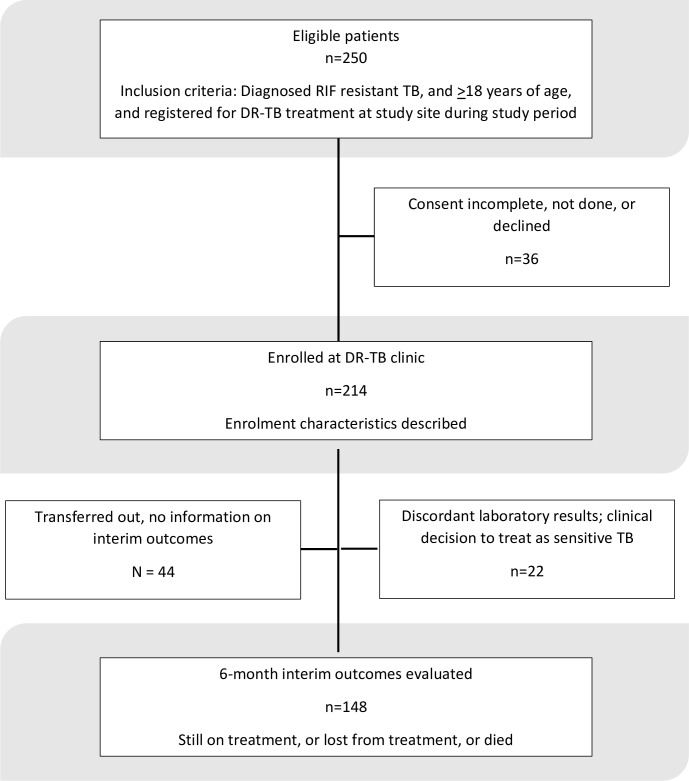
Description of cohort.